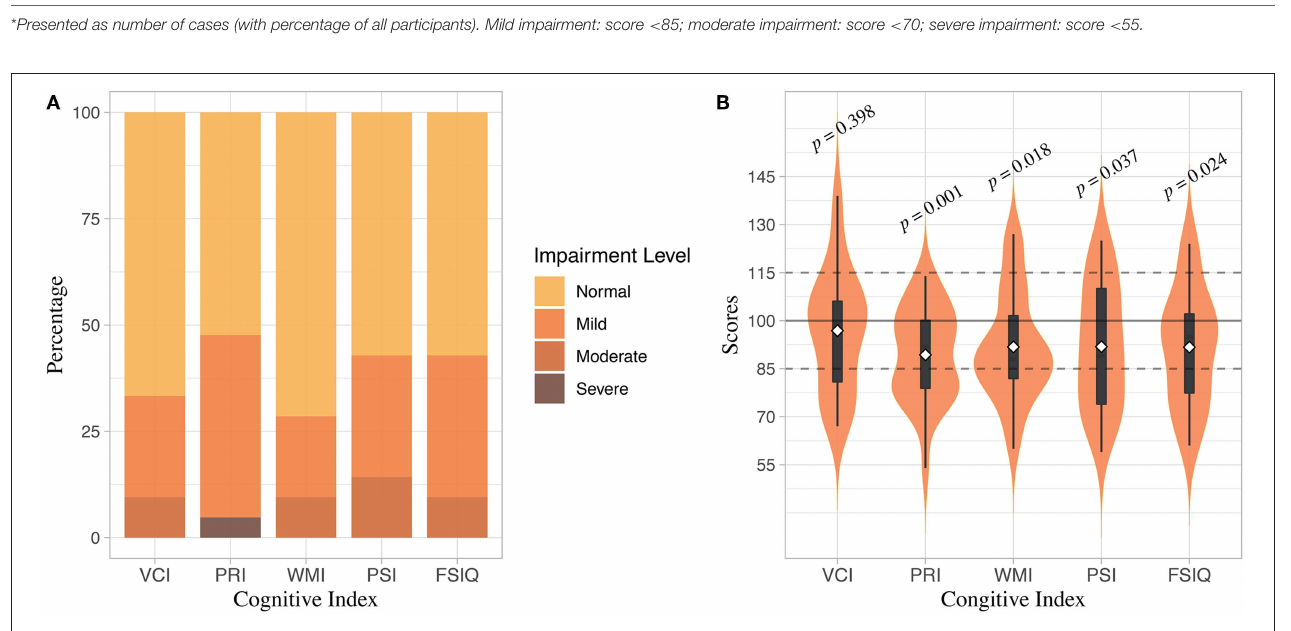
FIGURE 1 | Distribution of WISC-IV Index scores. (A) Distribution of cognitive impairment severity represented by different index scores. (B) Distribution of WISC-IV index scores. Upper and lower edges of black boxes denote the third and first quantile of index scores, and white dots denote means of index scores. P -value of t -test comparing index scores of participants to the mean scores of normative data were